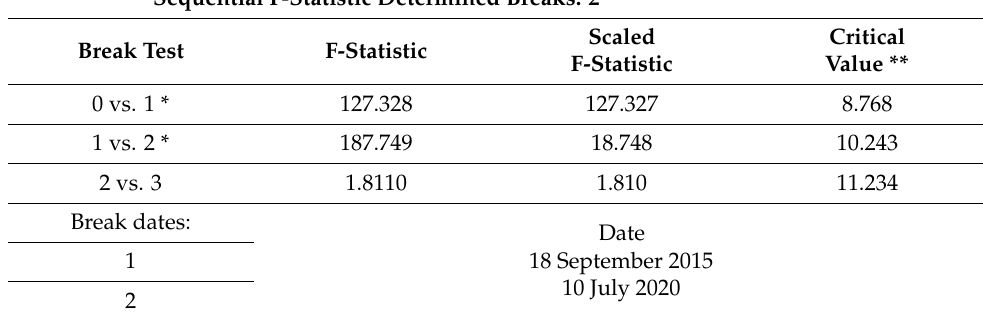
Table 6. Bai-Perron test for oil return